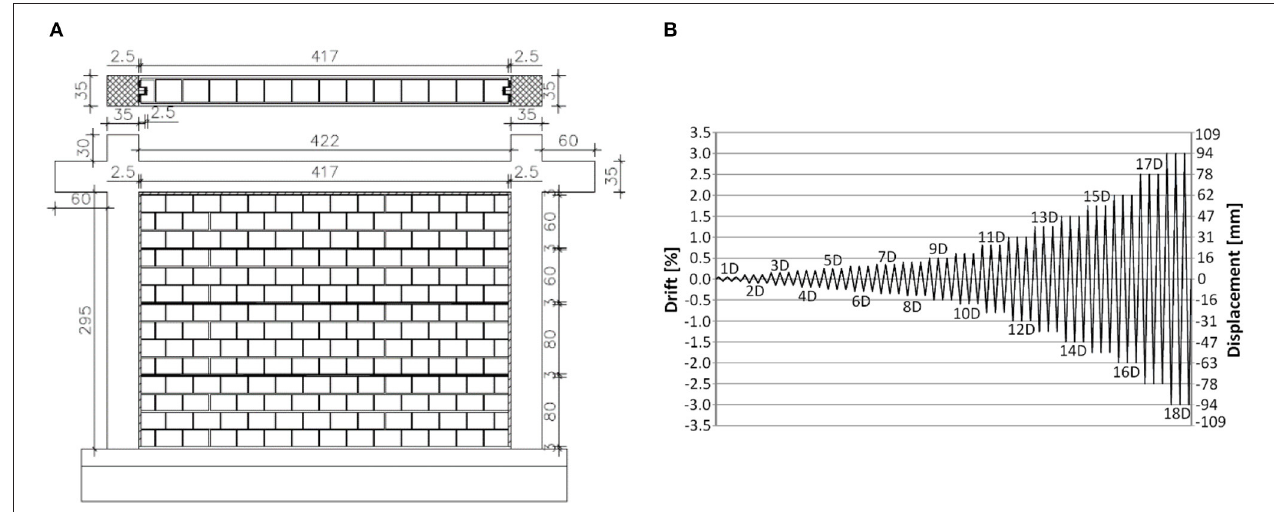
FIGURE 6 | (A) Layout of the fully infilled reinforced concrete (RC) frame specimen (TSJ1) represented without plaster. Measures in cm. (B) In-plane testing protocol for “low-velocity” test.